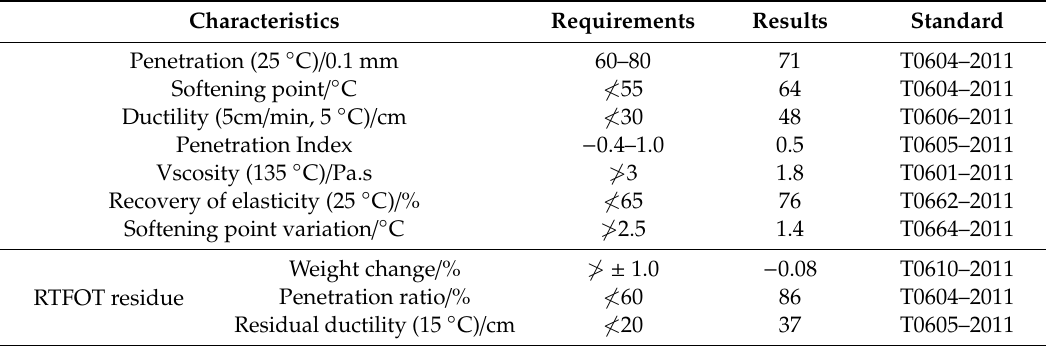
Table 1. Basic physical characteristics of the asphalt.